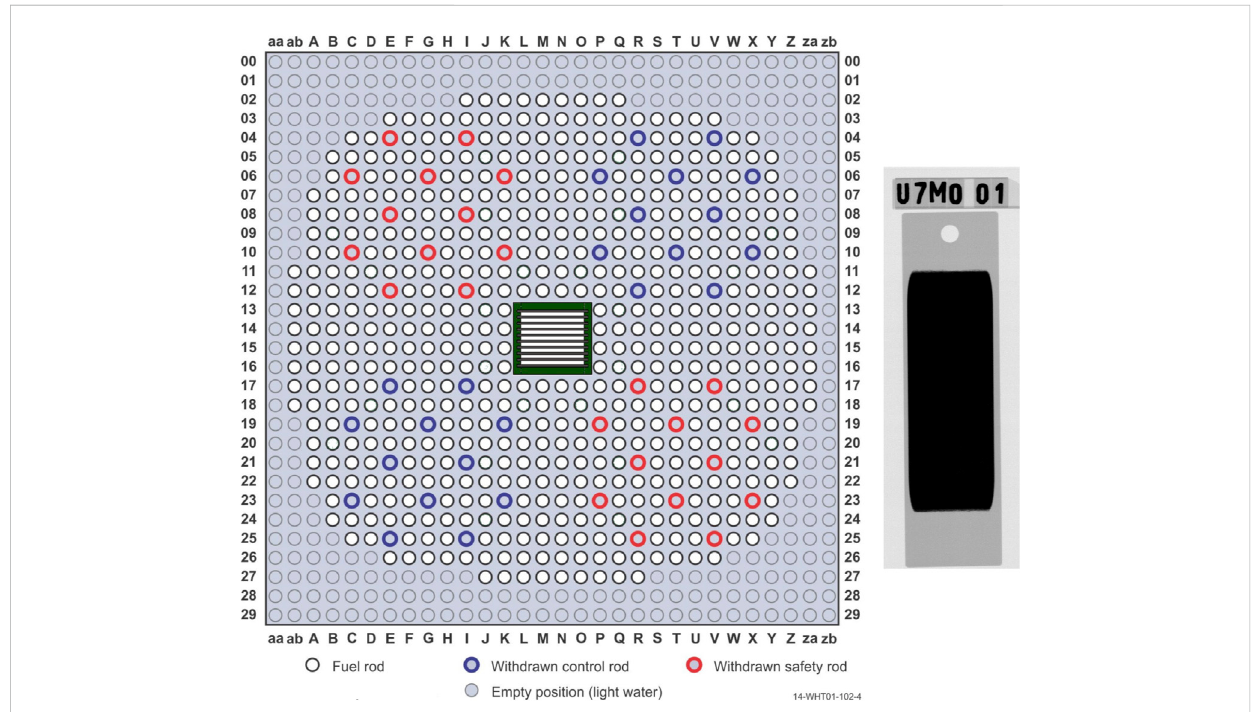
Schematic of IPEN MB-01 reactor core loading (Left) and X-Ray of a UMo fuel plate